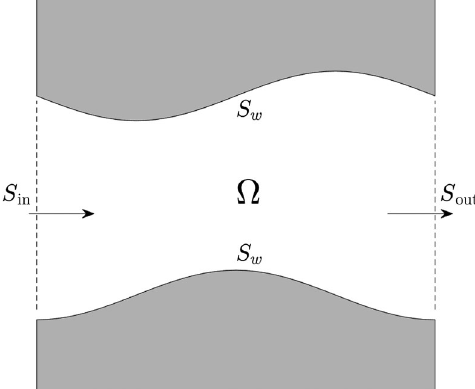
FIG. 2. Flow through a channel Ω with inflow surface S outflow surface S